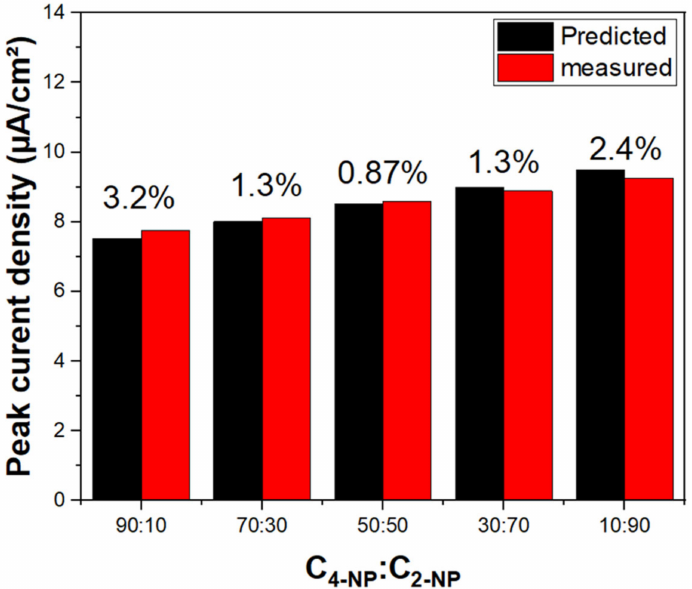
Figure 10. Nonselective detection of 2-NP and 4-NP with Ag@P-CA at different concentration ratios (C 4-NP : C 2-NP ). The numbers above columns represent the error (%) based on the measured current densities compared to the predicted ones. Predicted current densities are based on the sum of calibration curves of 2-NP and 4-NP. The experiments were performed in PBS-7 buffer solution. In general, the rate of various processes, such as (a) mass transfer, (b) electron